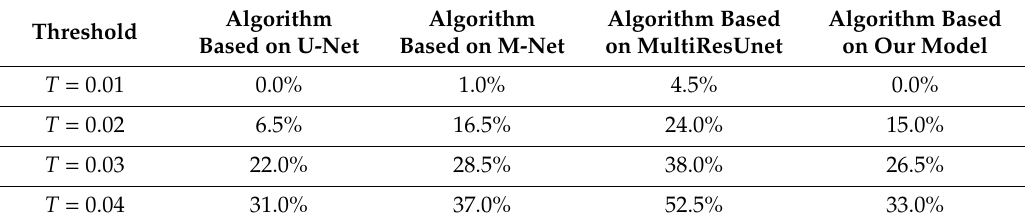
Table 8. Omission factor of sensitivity to tampering with changing